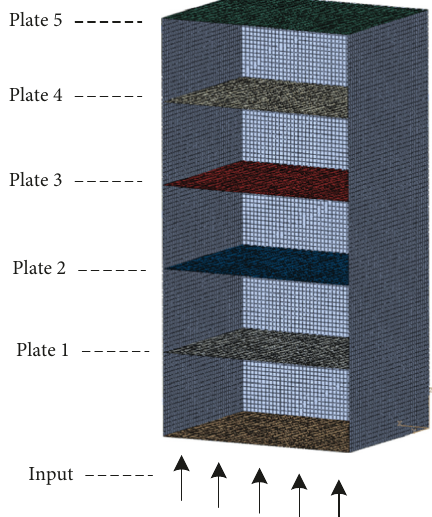
Figure 11: Model of multiplates frame structure.